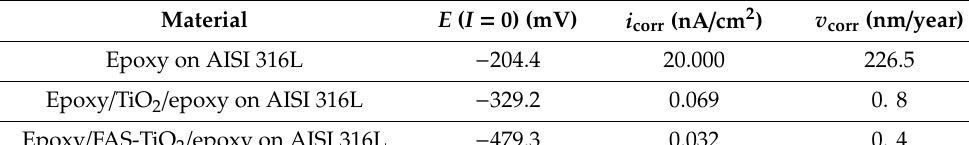
Table 2. Electrochemical parameters determined from the potentiodynamic curves.